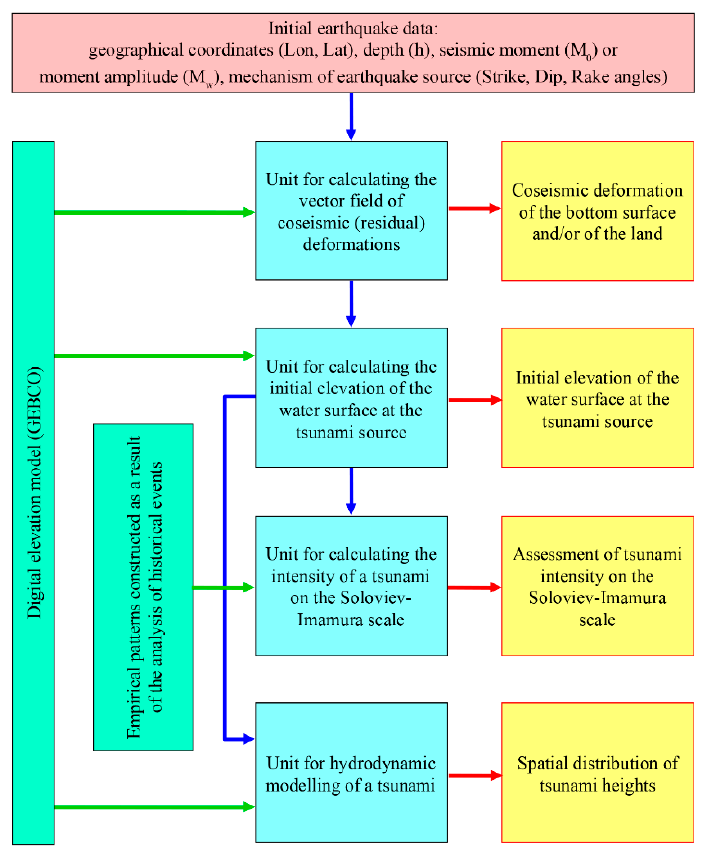
Figure 1. Architecture of the “Tsunami Observer” system.